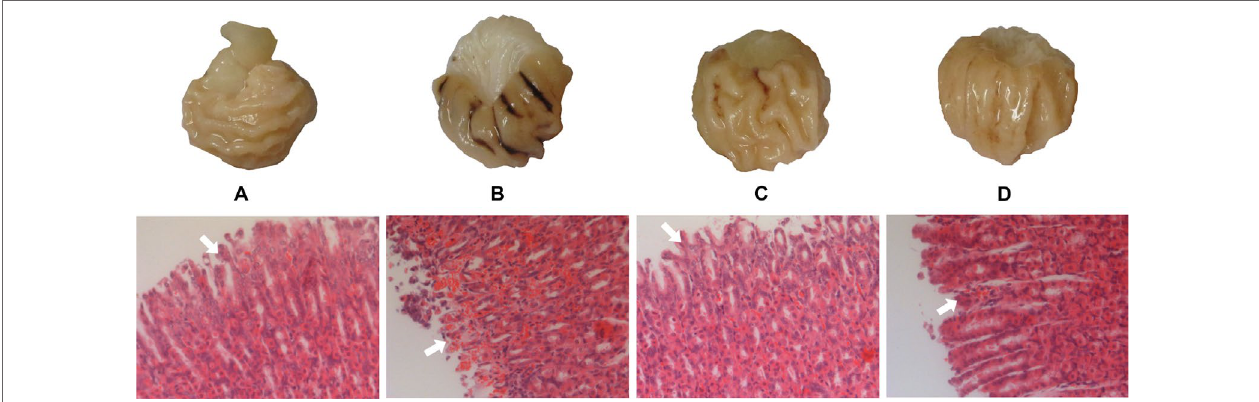
FIGURE 1 | Macroscopic appearance and histological evaluation of gastric mucosa in rats with ethanol-induced gastric mucosal damage. (A) Normal control group; (B) model group treated with absolute ethanol; (C) Gardenia Fructus (GF) group at a dose of 4.5 g∙kg −1 ; (D) carbonized GF (GFC) group at a dose of 4.5 g∙kg −1 . There were six rats in each group. Gross observation revealed that the area of hemorrhagic gastric mucosa was markedly decreased in the GF and GFC groups. Moreover, histological analysis showed that GF and GFC exerted a protective effect on mucosa (white arrow) of rats with ethanol-induced gastric mucosa damage (hematoxylin and eosin staining magnification 10 ×